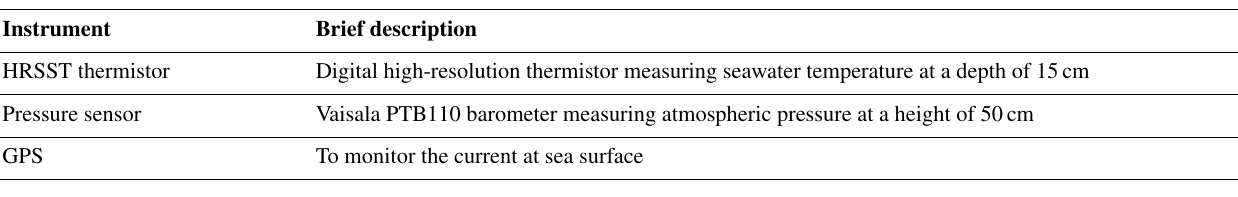
Table B28. SVP-BRST drifters.